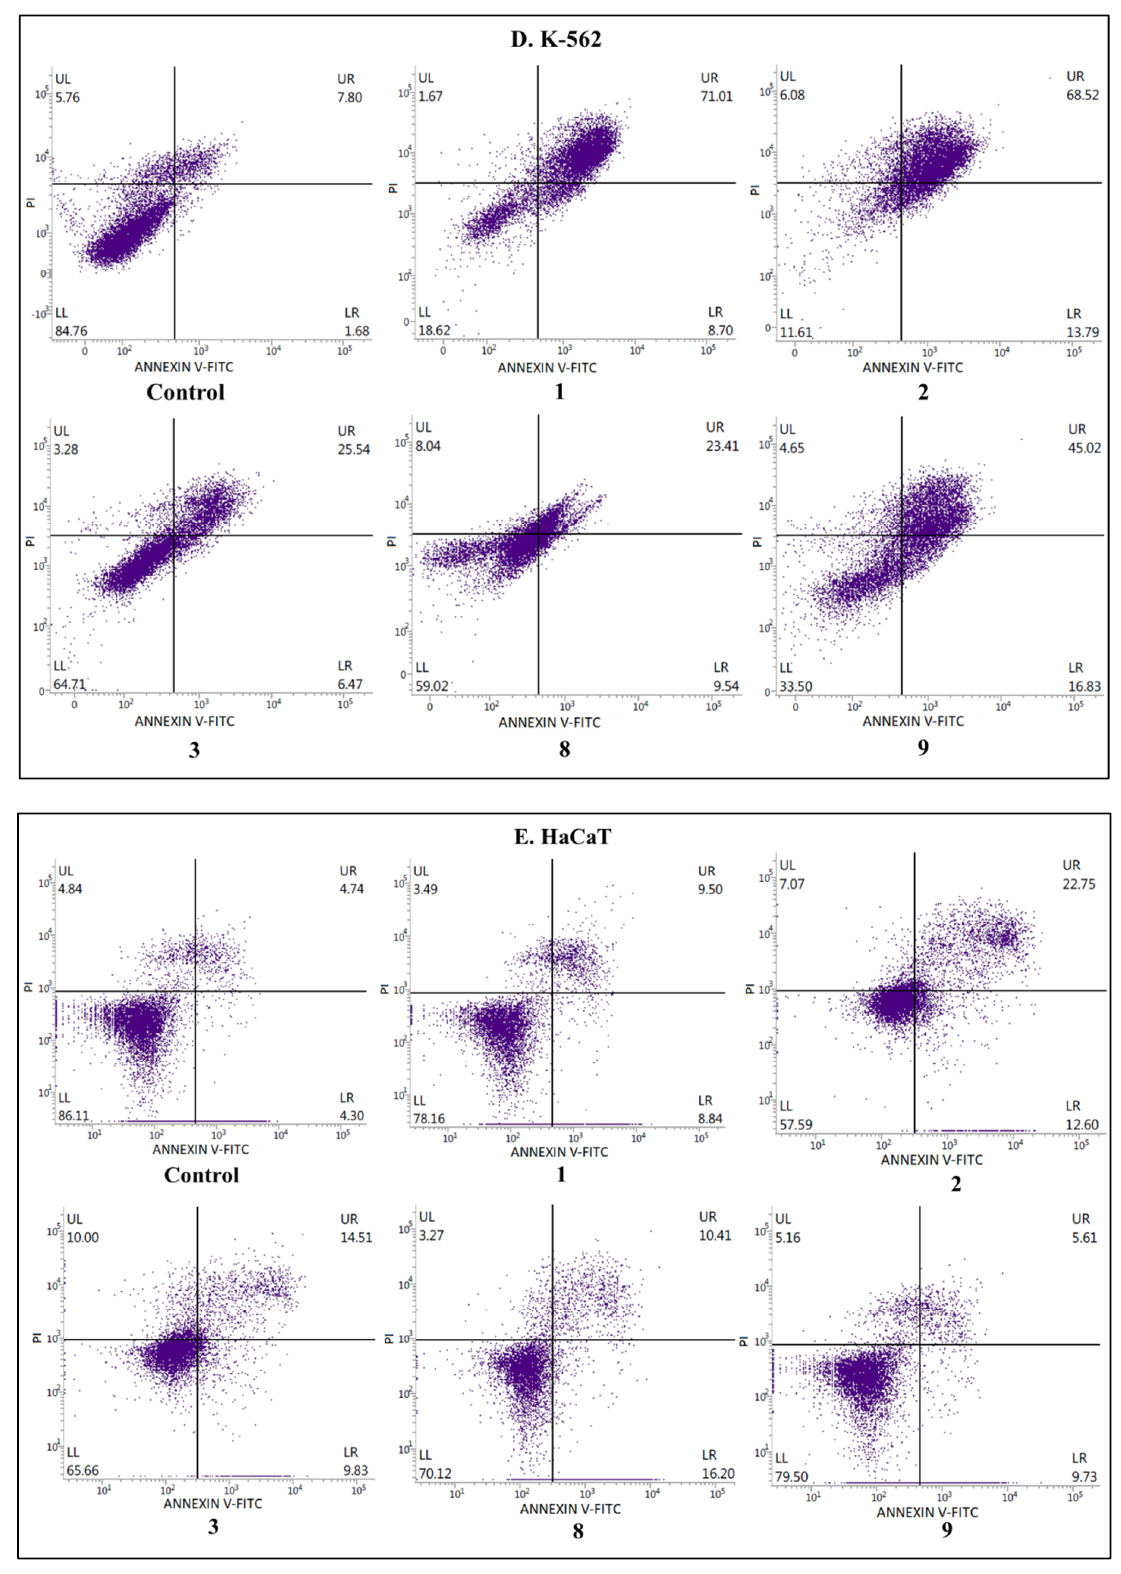
Figure 4. The effects of compounds 1 , 2 , 3 , 8 , and 9 on early and late apoptosis or necrosis in ( A ) SW480, ( B ) SW620, ( C ) PC3, ( D ) K-562, and ( E ) HaCaT cells detected with Annexin V-FITC/PI by flow cytometry. Cells were incubated for 72 h with the tested compounds. Dot plot diagrams show representative experiments. The lower left (LL) quadrant represents viable cells and the lower right (LR) quadrant early apoptotic cells. The upper right (UR) quadrant contains late-stage apoptotic cells, and the upper left (UL) quadrant necrotic cells.